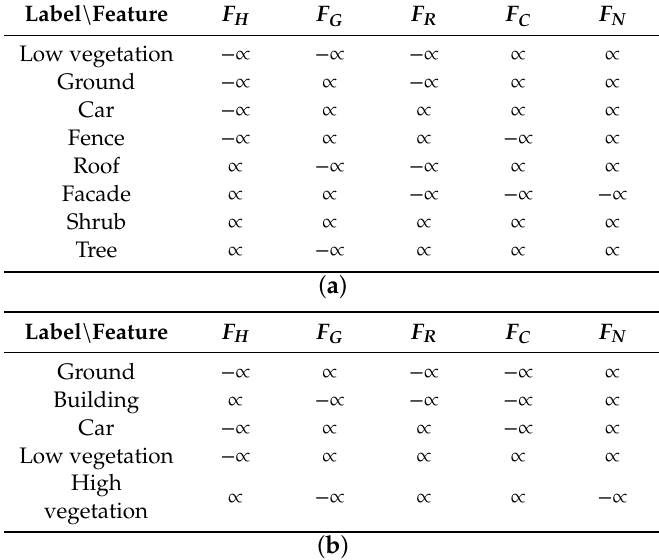
Table 2. Perception of the features for each class. Respectively, the symbols “ ∝ ” and “ −∝ “, indicate the feature value that tends to be large or small in the corresponding